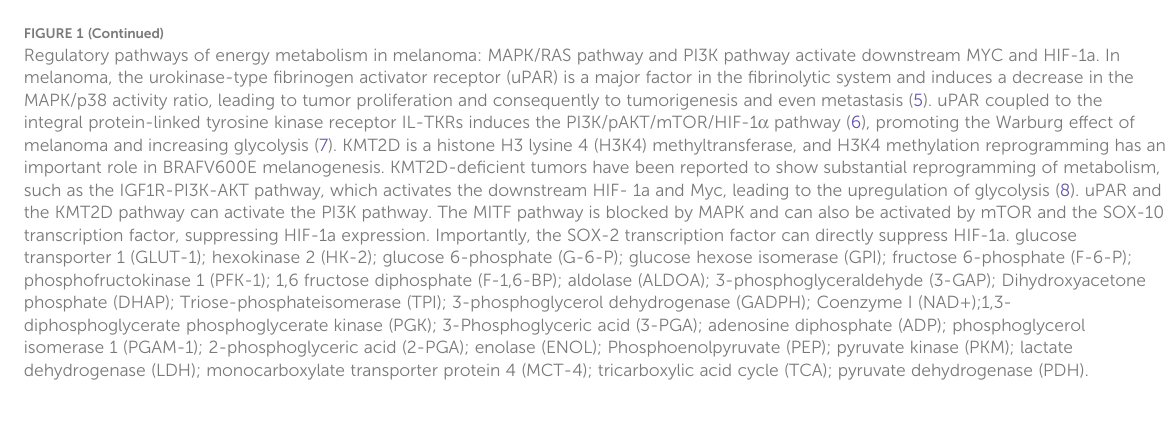
FIGURE 1 (Continued) Regulatory pathways of energy metabolism in melanoma: MAPK/RAS pathway and PI3K pathway activate downstream MYC and HIF-1a. In melanoma, the urokinase-type fi brinogen activator receptor (uPAR) is a major factor in the fi brinolytic system and induces a decrease in the MAPK/p38 activity ratio, leading to tumor proliferation and consequently to tumorigenesis and even metastasis (5). uPAR coupled to the integral protein-linked tyrosine kinase receptor IL-TKRs induces the PI3K/pAKT/mTOR/HIF-1 a pathway (6), promoting the Warburg effect of melanoma and increasing glycolysis (7). KMT2D is a histone H3 lysine 4 (H3K4) methyltransferase, and H3K4 methylation reprogramming has an important role in BRAFV600E melanogenesis. KMT2D-de fi cient tumors have been reported to show substantial reprogramming of metabolism, such as the IGF1R-PI3K-AKT pathway, which activates the downstream HIF- 1a and Myc, leading to the upregulation of glycolysis (8). uPAR and the KMT2D pathway can activate the PI3K pathway. The MITF pathway is blocked by MAPK and can also be activated by mTOR and the SOX-10 transcription factor, suppressing HIF-1a expression. Importantly, the SOX-2 transcription factor can directly suppress HIF-1a. glucose transporter 1 (GLUT-1); hexokinase 2 (HK-2); glucose 6-phosphate (G-6-P); glucose hexose isomerase (GPI); fructose 6-phosphate (F-6-P); phosphofructokinase 1 (PFK-1); 1,6 fructose diphosphate (F-1,6-BP); aldolase (ALDOA); 3-phosphoglyceraldehyde (3-GAP); Dihydroxyacetone phosphate (DHAP); Triose-phosphateisomerase (TPI); 3-phosphoglycerol dehydrogenase (GADPH); Coenzyme I (NAD+);1,3- diphosphoglycerate phosphoglycerate kinase (PGK); 3-Phosphoglyceric acid (3-PGA); adenosine diphosphate (ADP);